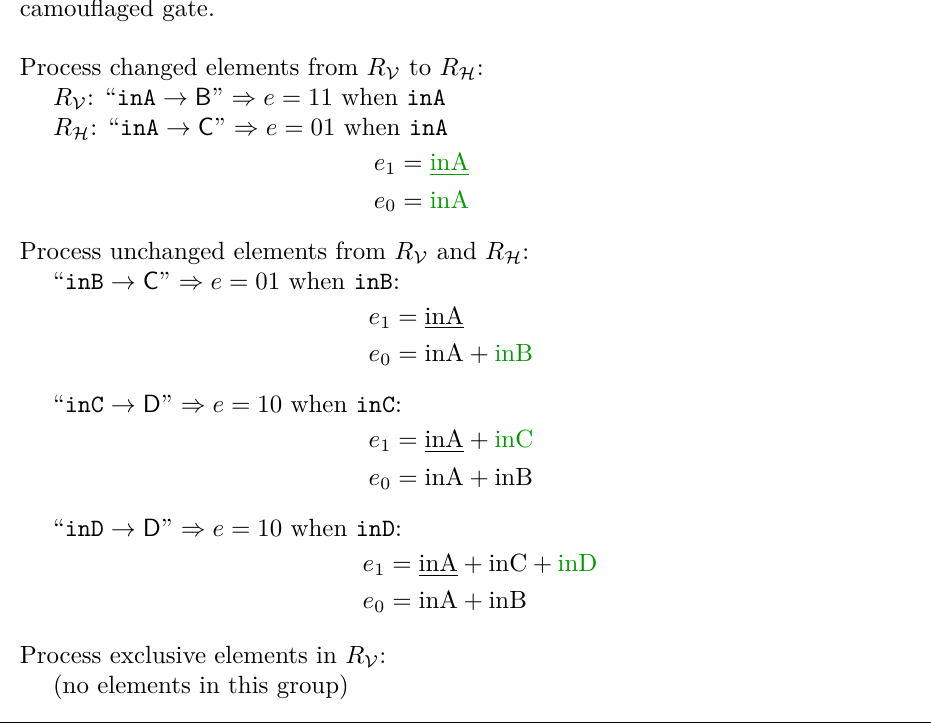
Figure 2: Rundown of the Doppelganger algorithm applied to the example from Section